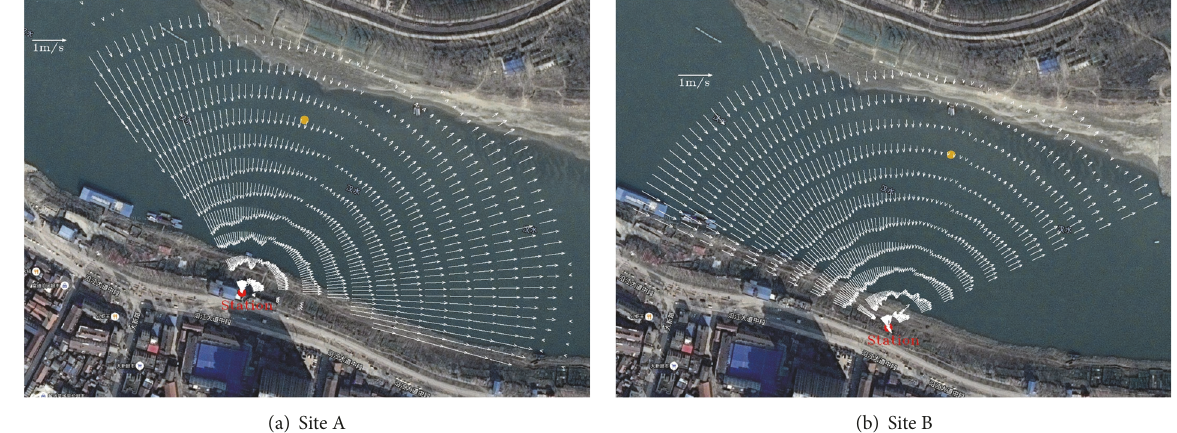
Figure 12: At 2016-7-20-7:05, the radial flow field obtained by two radars.